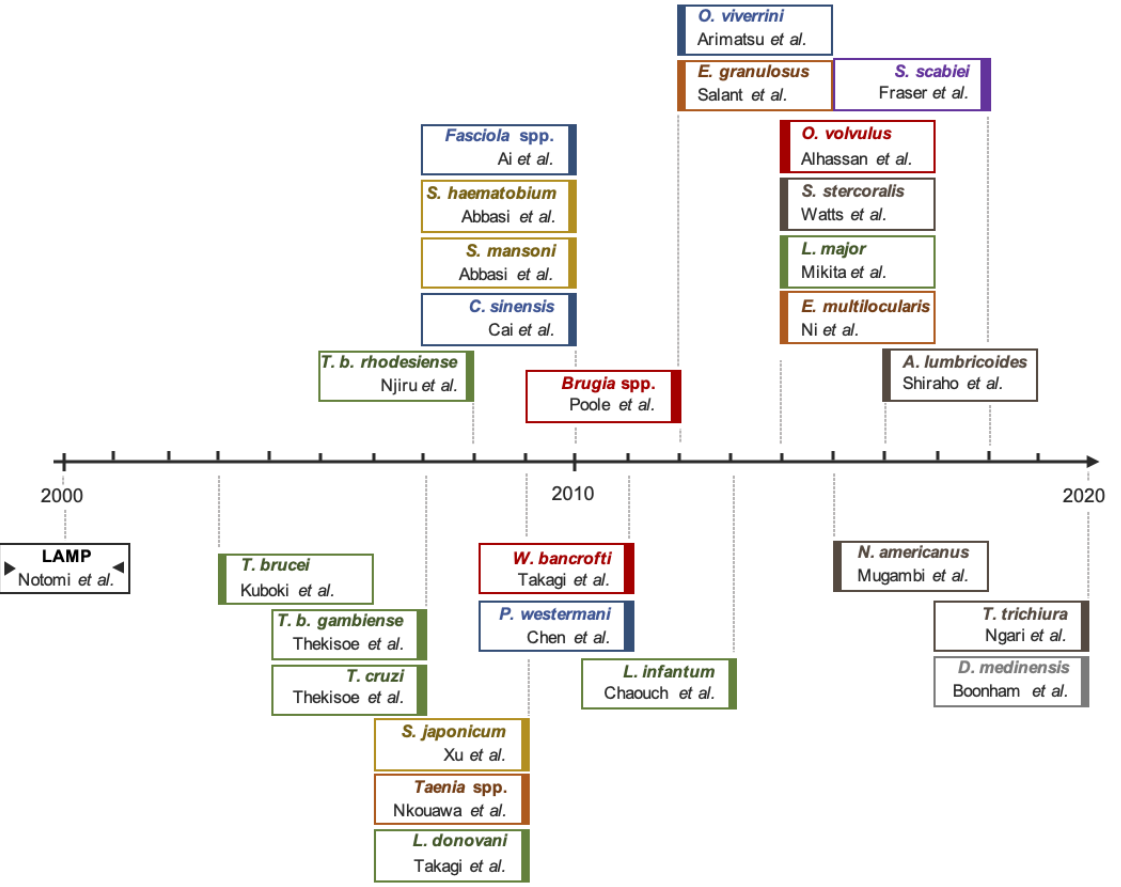
Figure 3. Timeline of first LAMP tests development for parasite-caused NTDs. Color code; orange, Cestodiases: Taenia spp., Echinococcus granulosus ( E. granulosus ) Echinococcus multilocularis ( E. multilocularis ); blue, Food-borne trematodiases: Fasciola spp., Clonorchis sinensis ( C. sinensis ) Paragonimus westermani ( P. westermani ), Opistorchis viverrini ( O. viverrini ); brown, Soil-transmitted helminthiasis: Strongyloides stercoralis ( S. stercoralis ), Necator americanus ( N. americanus ), Ascaris lumbricoides ( A. lumbricoides ), Trichuris trichiura ( T. trichiura ); green, Protozoa: Trypanosoma brucei ( T. brucei ), Trypanosoma brucei gambiense ( T. b. gambiense ), Trypanosoma brucei rhodesiense ( T. b. rhodesiense ), Trypanosoma cruzi ( T. cruzi ), Leishmania infantum ( L. infantum ) and Leishmania major ( L. major ); grey, Dracunculiasis: Dracunculus medinensis ( D. medinensis ); red, Lymphatic filariasis: Brugia spp., Wuchereria bancrofti ( W. bancrofti ) and Onchocerca volvulus ( O. volvulus ); violet, Scabies: Sarcoptes scabei ( S. scabei ); yellow, Schistosomiasis: Schistosoma mansoni ( S. mansoni ), Schistosoma haematobium ( S. haematobium ) and S. japonicum ( S. japonicum ). References in the figure: Notomi et al. [11], Kuboki et al. [25], Thekisoe et al. [26],